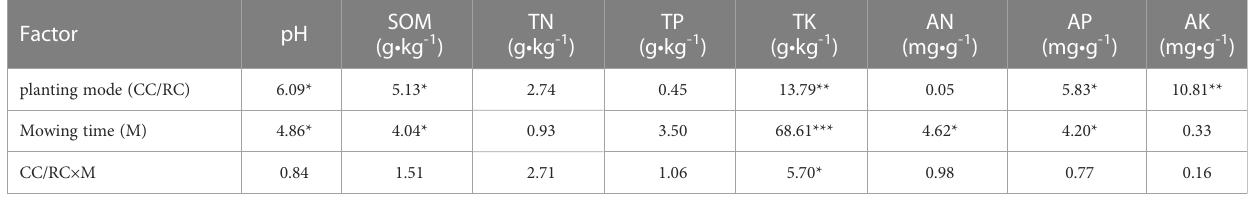
TABLE 1 Two-way ANOVA analysis of effects of the planting mode and mowing time on soil physicochemical properties.